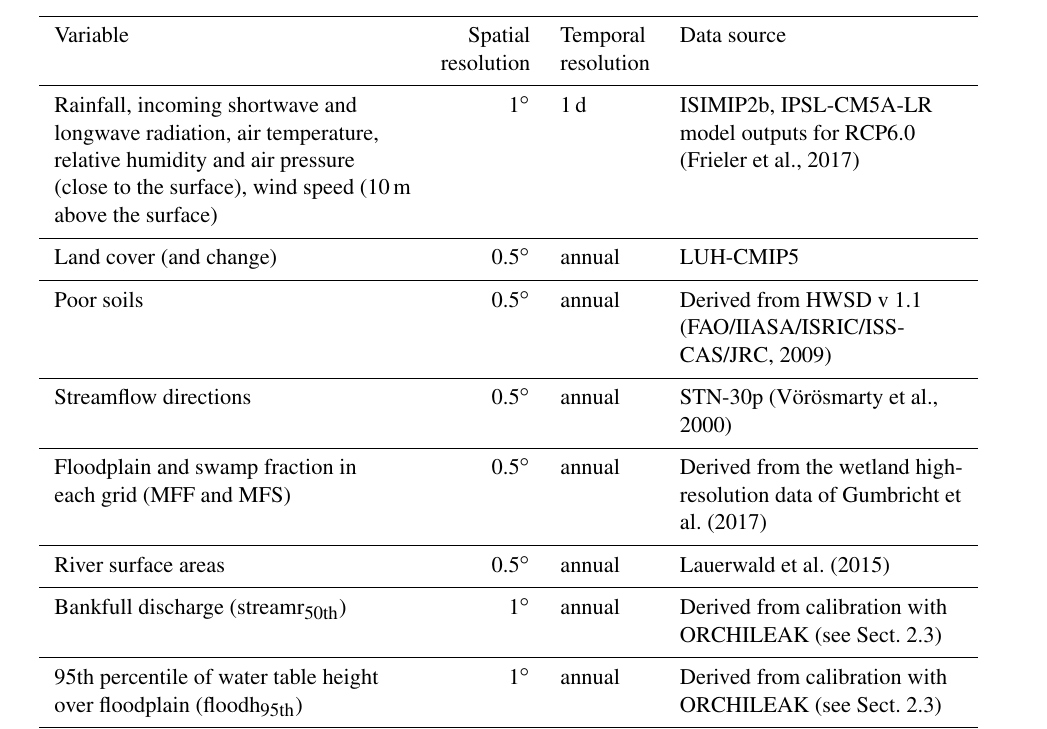
Table 1. Main forcing files used for simulations.